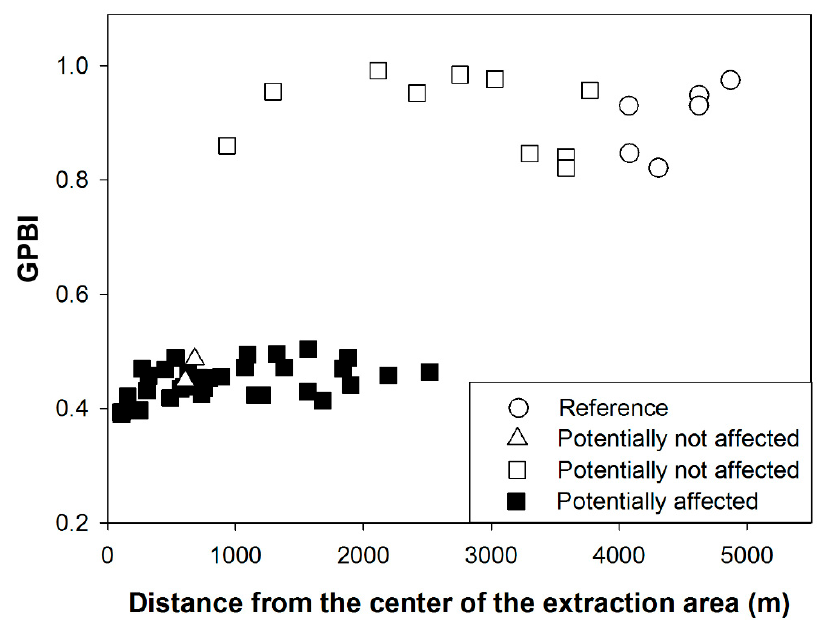
Figure 2. Case Study 1—maerl extraction in Glénan Archipelago (France, northern Bay of Biscay). Relationships between pressure levels, as indicated by geographical distances from the center of the maerl extraction area, and GPBI.